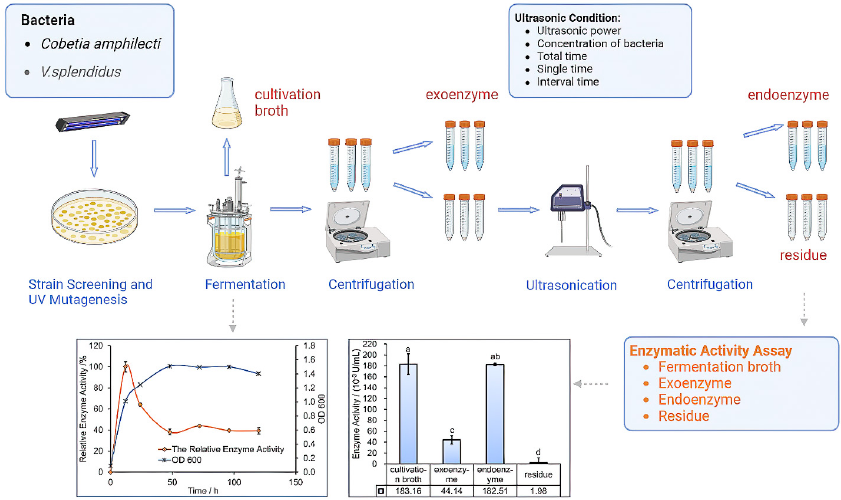
Figure 2. Strain screening and extraction of fucoidanase. The same letters of a, b, c and d mean the difference among groups is not significant, and different letters represent significant differences ( p < 0.05).